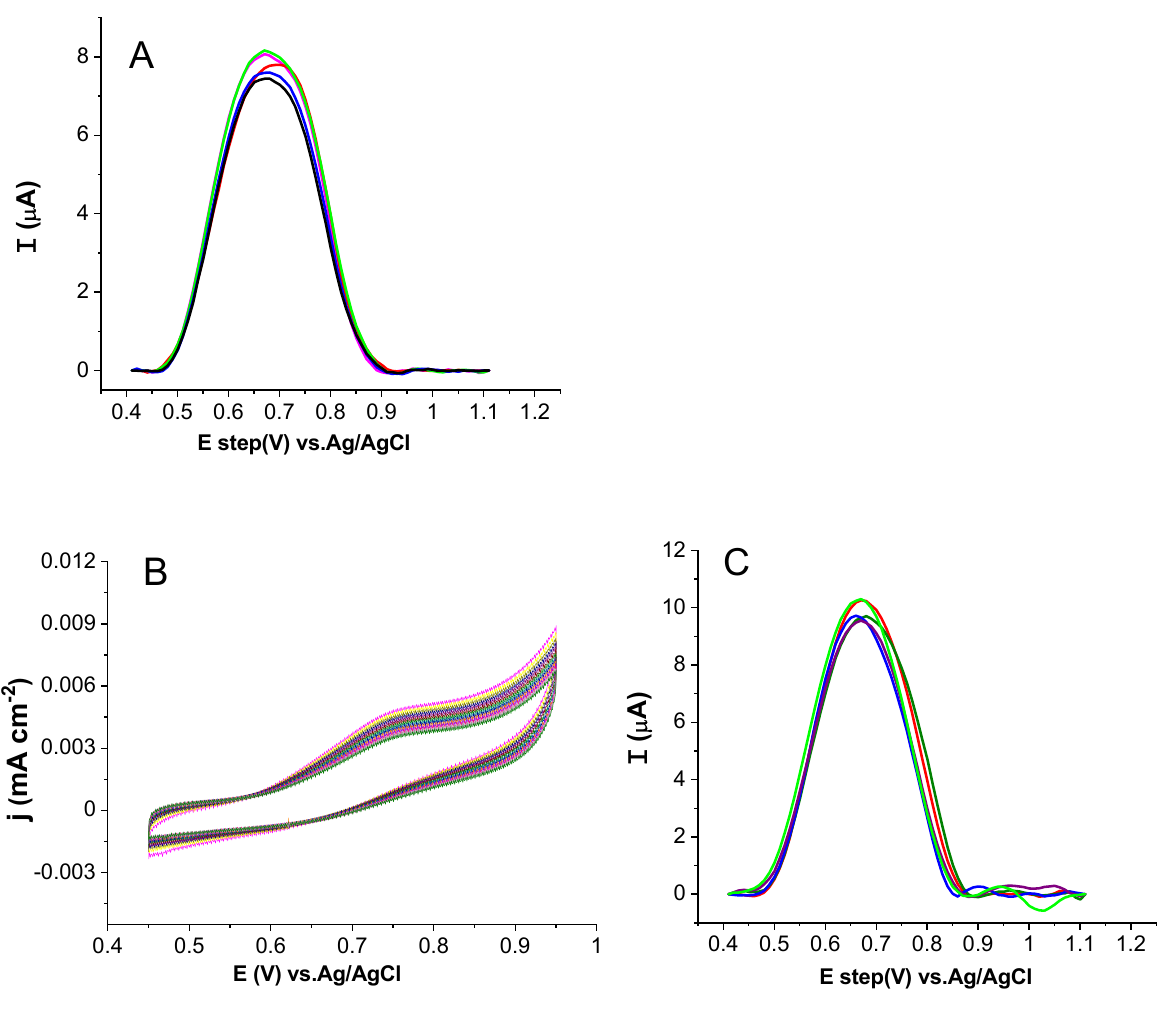
Figure 11. ( A ) A series of five SWV measurements, ( B ) 20 sequences of CV measurements from − 0.45 to 0.95 V at 100 mV/s, and ( C ) two weeks of SWV measurements of the AuNPs/CPE in 250 μM CR in 0.1 M ABS at pH 6.5.